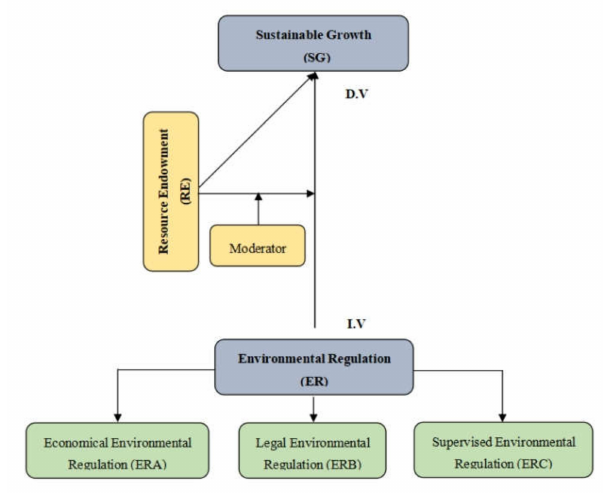
Figure 1. Conceptual